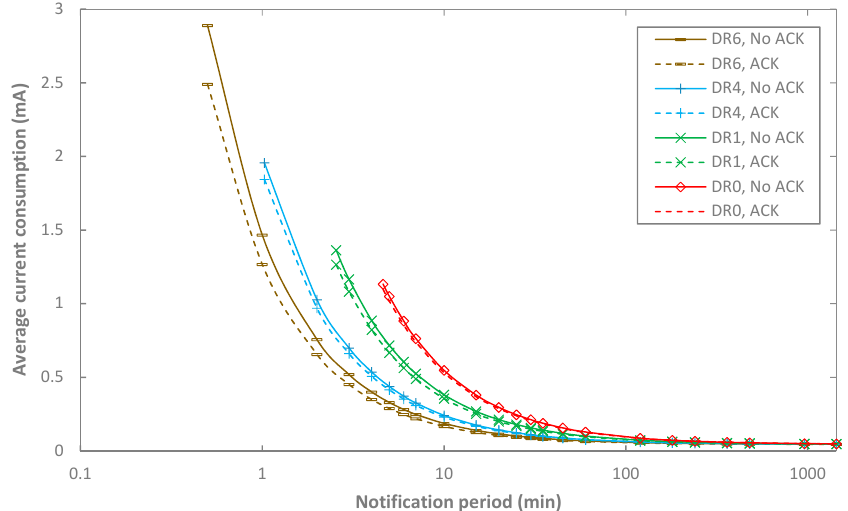
Figure 9. Comparison of the average current consumption of the end-device in acknowledged and unacknowledged transmission, as a function of T Notif , and for different DR settings, for BER = 0 and p coll = 0. DR2, DR3 and DR5 are not shown in the figure for the sake of illustration clarity.